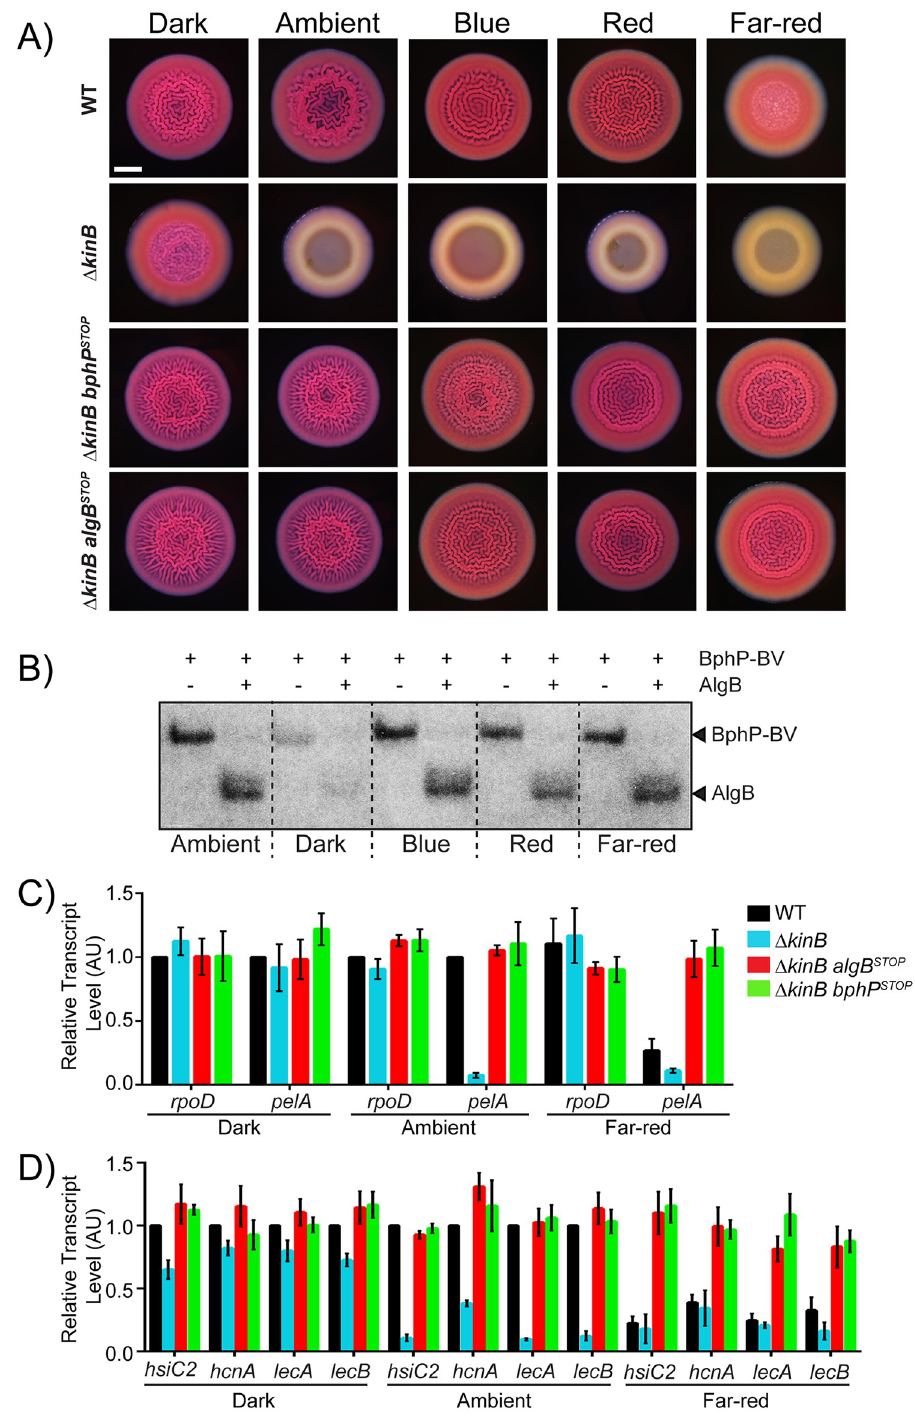
Fig 4. Photosensing, via the BphP–AlgB phosphorelay, represses group behaviors in P . aeruginosa . (A) Colony biofilm phenotypes are shown for WT PA14 and the designated mutants on Congo red agar medium after 72 h of growth under the indicated light conditions. Scale bar is 2 mm for all images. (B) Autophosphorylation of the BphP– BV complex was carried out for 30 min (left lane in each pair), followed by addition of AlgB (right lane in each pair) for an additional 30 min under the indicated light conditions. (C) Relative expression of rpoD and pelA as measured by qRT-PCR in WT PA14 and the designated mutant strains grown as colony biofilms as in (A) in darkness, ambient light, and far-red light. (D) Relative expression of hsiC2 , hcnA , lecA , and lecB measured by qRT-PCR in WT PA14